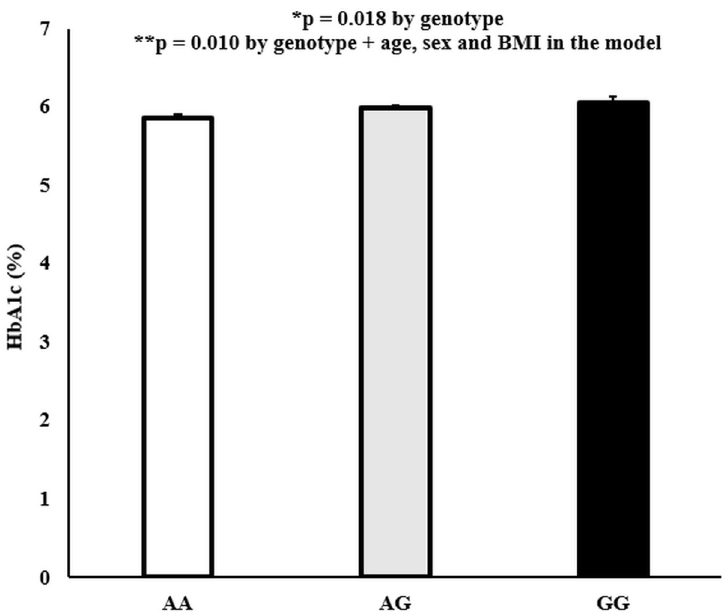
Fig 1. EDARV370A genotypes by HbA1c (%) levels. Values are mean ± SEM. P values were generated using a simple linear regression model.